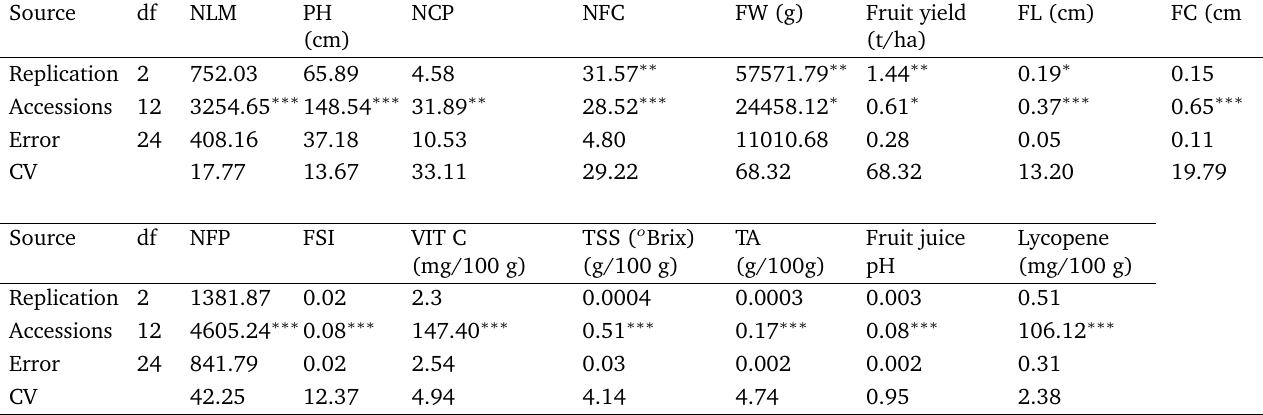
Table 2. Mean squares from analysis of variance of agronomic, nutritional andphysicochemical traits of wild tomato